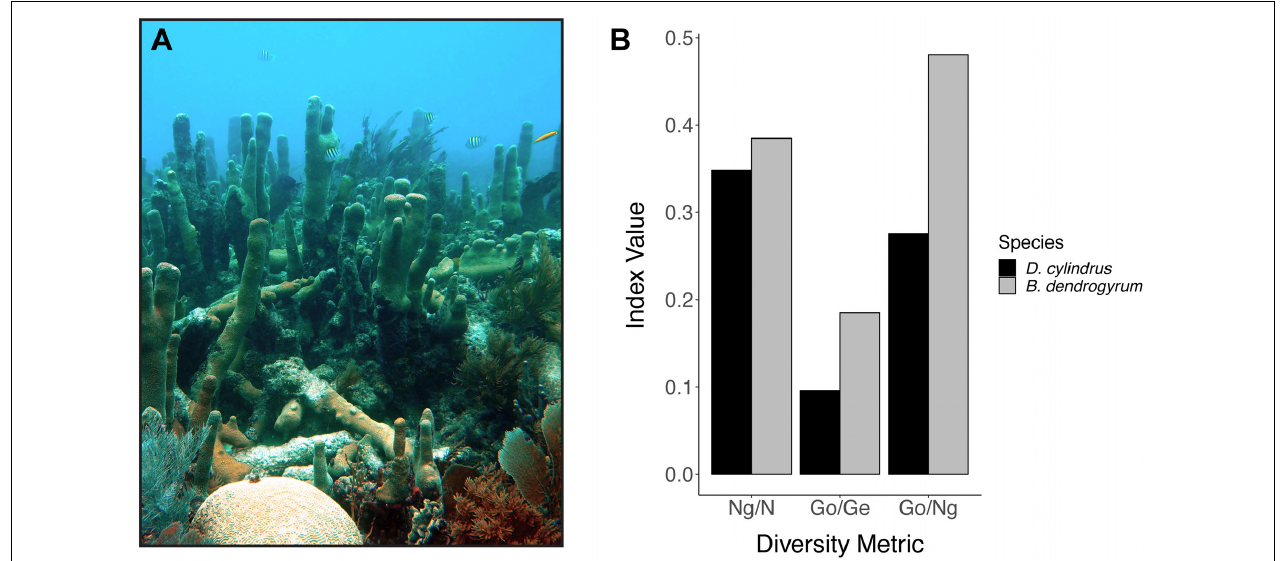
FIGURE 2 | (A) Photo of multiple colonies of Dendrogyra cylindrus , including a recently fragmented colony with new pillar growth in the foreground (photo credit: Iliana Baums). (B) Summary of the clonal structure of Dendrogyra cylindrus and its dominant algal symbiont Breviolum dendrogyrum in Florida. Genotypic richness ( N g /N ), diversity ( G o /G e ), and evenness ( G o /N g ) are plotted on the x -axis and the value of the diversity index is plotted on the y -axis. N g , number of genotypes; N , number of colonies sampled; G o , observed genotypic diversity; G e , expected genotypic diversity.